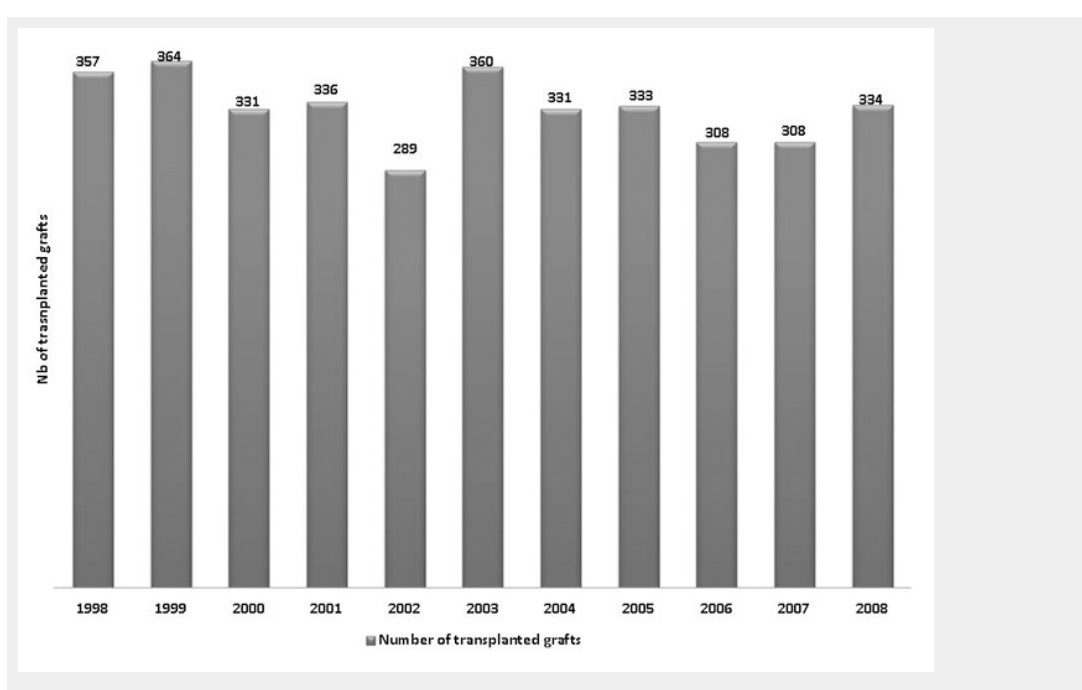
Figure 6 Number of transplanted solid organs in Switzerland. Results displayed for organs procured from deceased donors. Living is not included in this